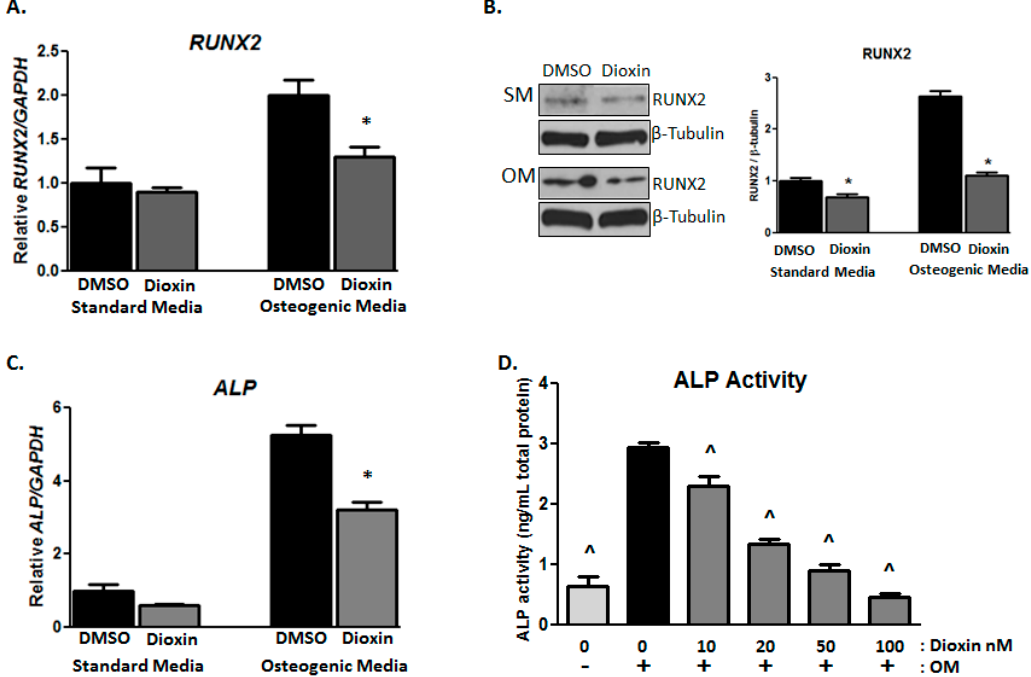
Figure 2. Dioxin inhibits early markers of osteogenic differentiation. ( A ) Under osteogenic conditions, dioxin significantly decreased RUNX2 mRNA expression; ( B ) Dioxin downregulated RUNX2 protein expression under both standard and osteogenic conditions; ( C , D ) Dioxin significantly inhibited the osteogenic media (OM)-induced expression of ALP mRNA. Similarly, dioxin dose-dependently inhibited ALP activity in differentiating cells . * p < 0.05 relative to 0 nM dioxin under standard or osteogenic conditions ( A – C ); ^ p < 0.05 relative to 0 nM dioxin under osteogenic conditions ( D ). Error bar means ± SEM.